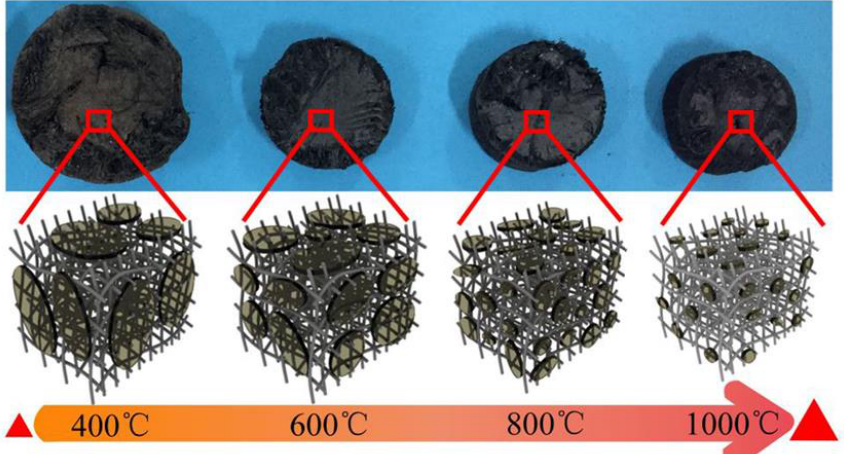
Figure 11. Schematic and optical micrographs showing the effect of carbonization temperature on the structures of carbonized cellulose nanofibril aerogels for supercapacitor applications. Reprinted with permission from [47]. Copyright © 2019 American Chemical Society.